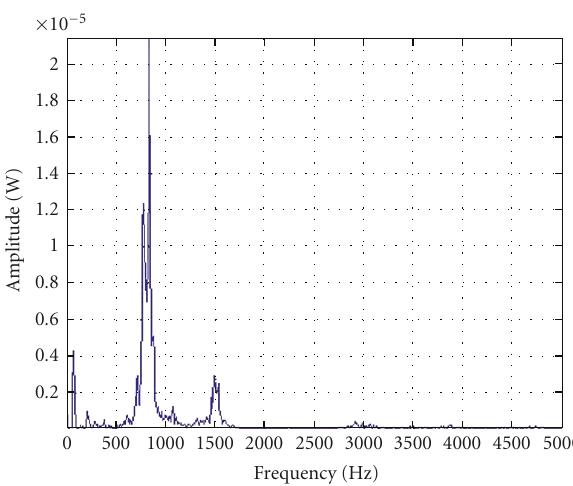
Figure 4: Vocal signal amplitude versus frequency (EV1).